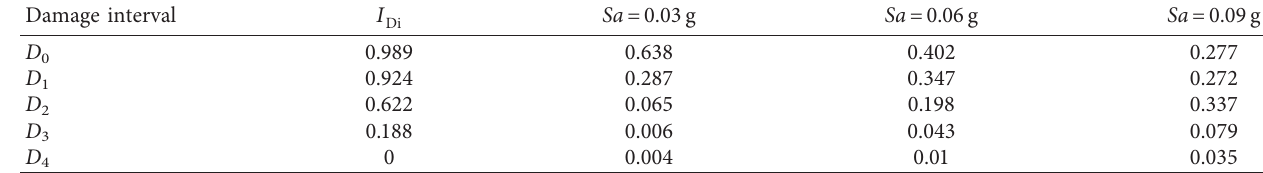
Table 6: Seismic resilience of the stage index and damage probability (section R-C).